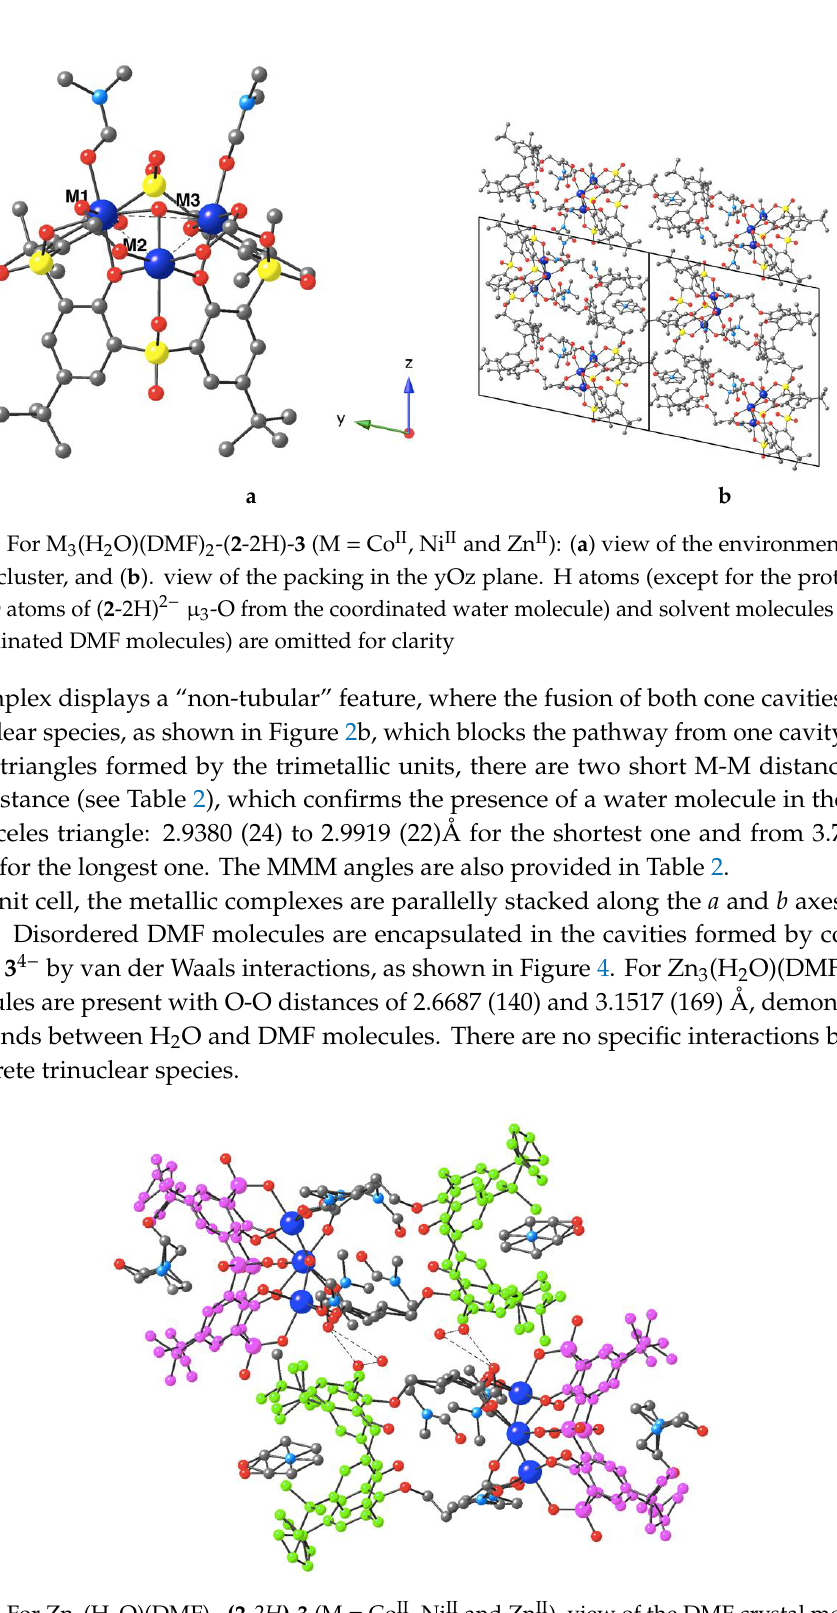
Figure 4. For Zn 3 (H 2 O)(DMF) 2 - (2 -2H )-3 (M = Co II , Ni II and Zn II ), view of the DMF crystal molecules encapsulated in the cones of ( 2- 2H) 2− (green) and 3 4− (pink) and the water molecules lying between the clusters. Table 2. The main distances for M 3 (H 2 O)(DMF) 2 -( 2 -2H)- 3 (M = Co II , Ni II and Zn II ) clusters.